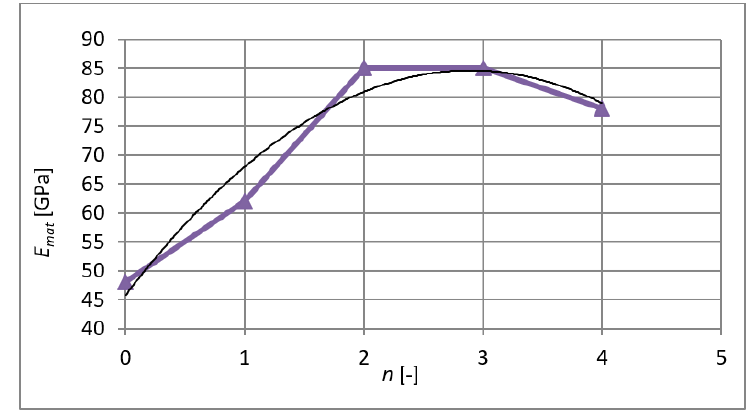
Figure 14. Evolution of the modulus of elasticity after individual extrusions. The quantity R expresses the tightness of the agreement according to the least- squares method to demonstrate extrusion trends, i.e., analytically (using a spreadsheet editor), the expression of the interleaved function and the objective, reproducible deter-